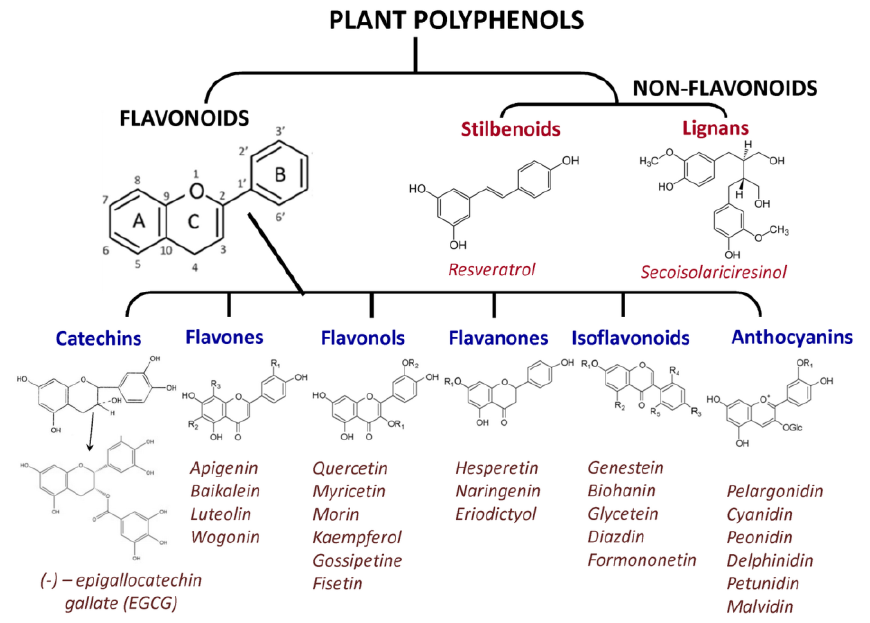
Figure 6. Plant polyphenols with known pharmacological properties.